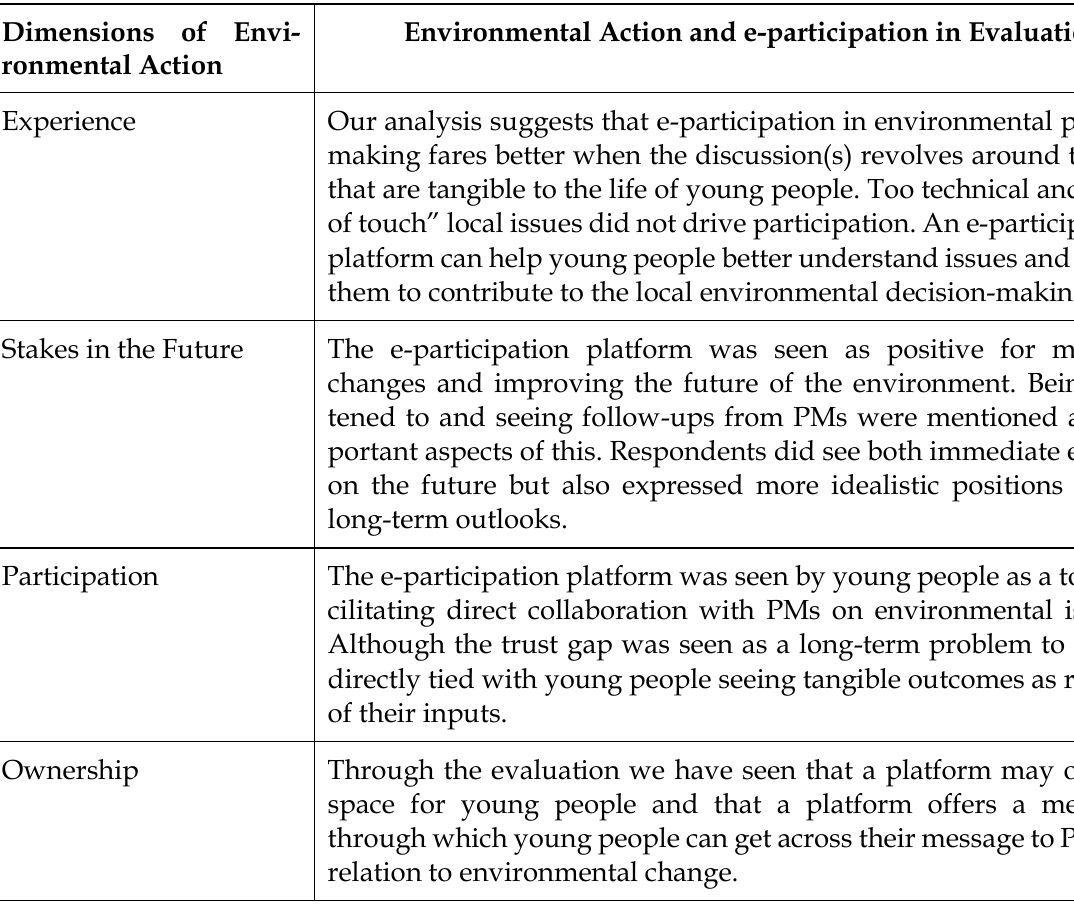
Table 4. Dimension of Environmental Action in e-participation